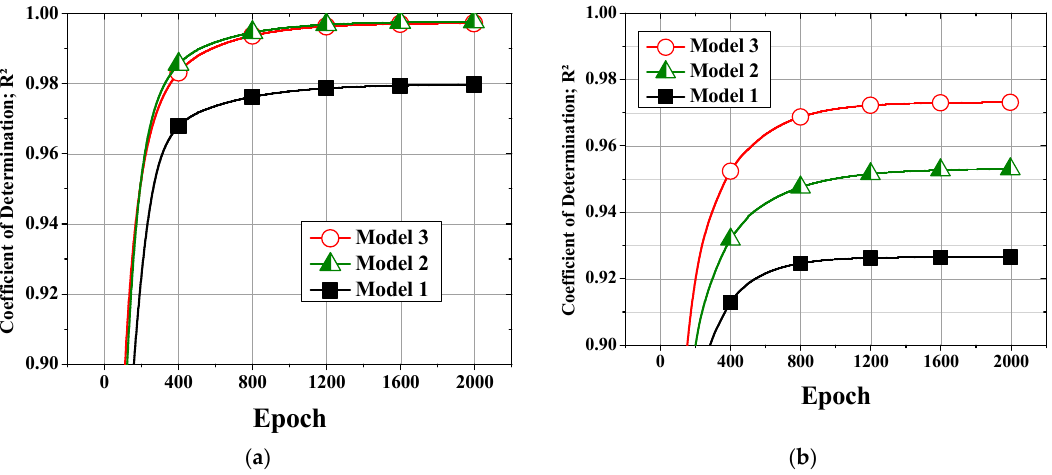
Figure 9. R 2 values of the ( a ) training and ( b ) validation datasets.